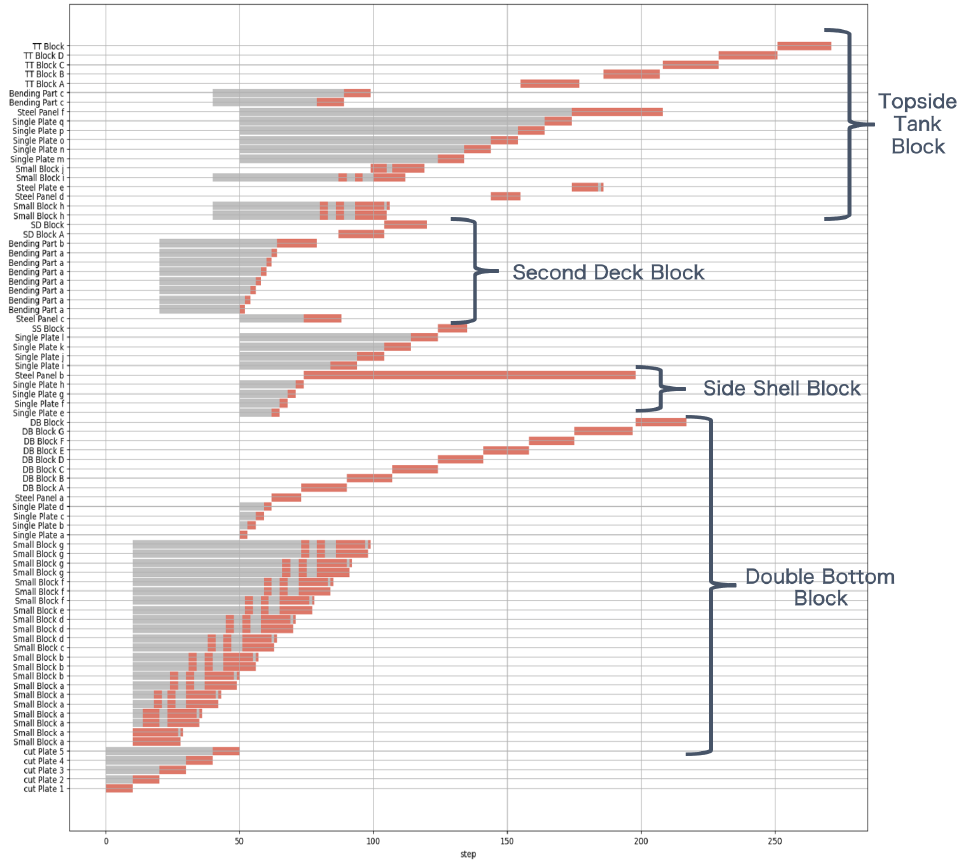
Figure 11. Result of Gantt Chart by Each